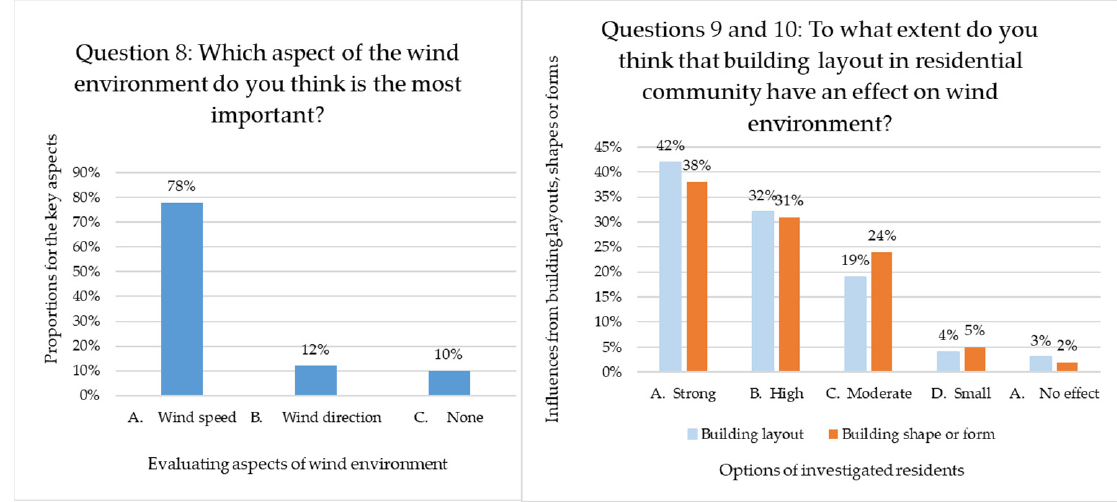
Figure 10. The survey results for Questions 8, 9, and 10 of the questionnaires.